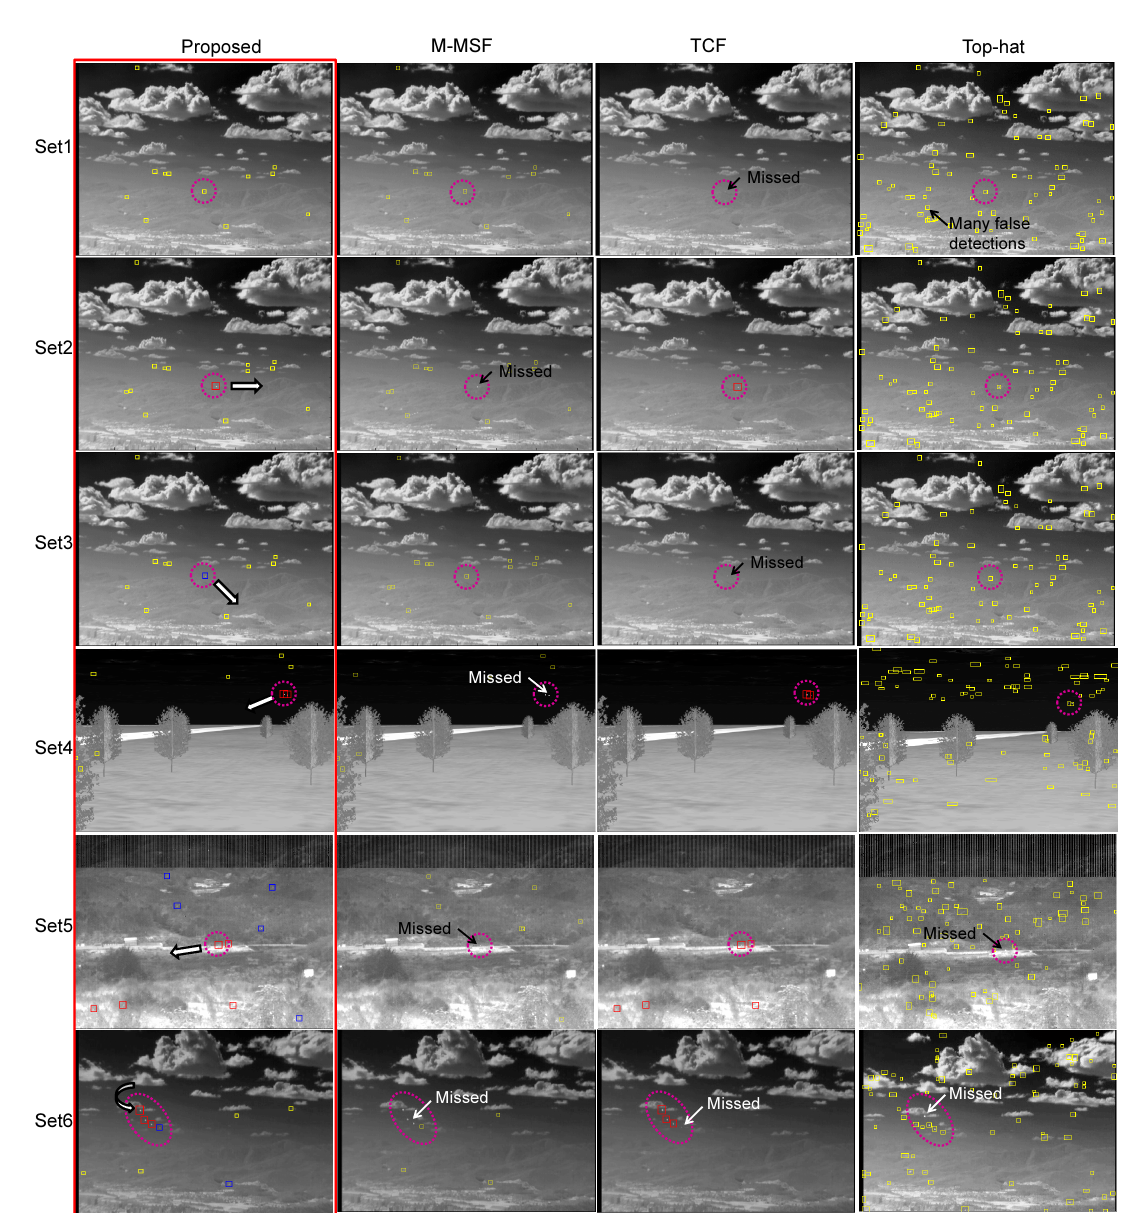
Figure 24. Performance comparison examples of the small target detection methods for the six kinds of test sets. The dotted circles represent the ground truth, and the rectangles represent detection